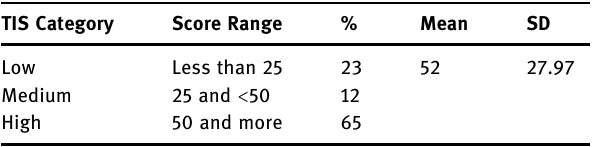
Table 5: Category based on TISs among